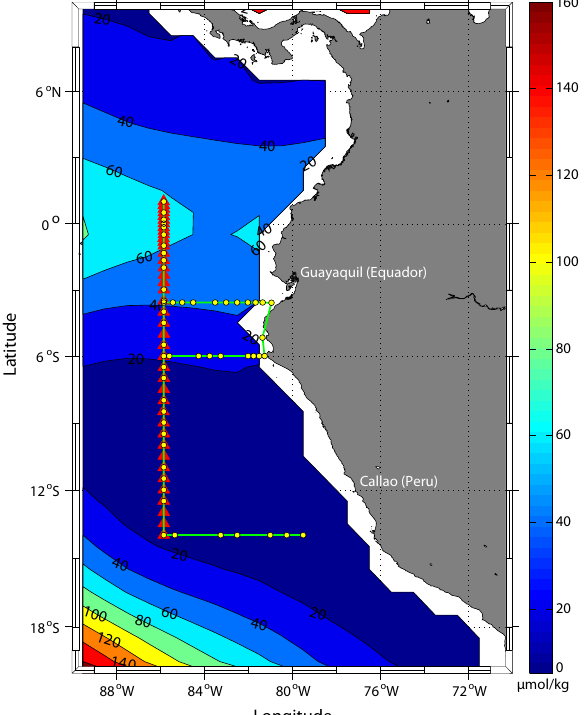
Longitude Fig. 1b. Circulation scheme for currents in the upper 200m (green lines) and 200–600m (blue dashed lines) layers based on descriptions provided by Kessler (2006), Czeschel et al. (2011) and Grasse et al. (2012); notice that some current bands may cover both depth layers. The current shown are: NECC – North Equatorial Counter Current, NSCC – Northern Subsurface Counter Current, NEIC – North Equatorial Intermediate Current, NICC – North Intermediate Counter Current, EIC – Equatorial Intermediate Current, EUC – Equatorial Undercurrent, SICC – South Intermediate Counter Current, SEIC – South Equatorial Intermediate Current, SSCC – Southern Subsurface Counter Current, SEC – South Equatorial Current, POC – Peru Oceanic Current, PCCC – Peru–Chile Counter Current, PCC/HC – Peru– Chile or Humboldt Current and PCUC – Peru–Chile Undercurrent. The inset shows the source regions (coloured) along the P19 cruise track, where the source water masses (Table 1) were defined.